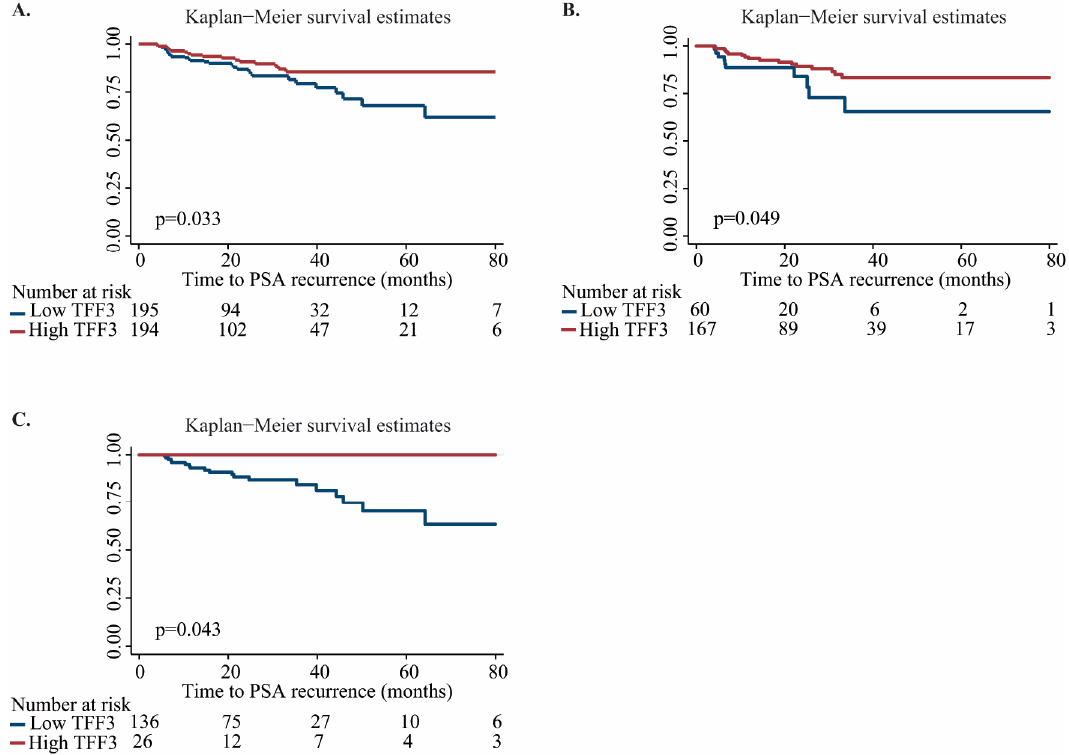
Figure 3. Kaplan–Meier analysis of PSA recurence-free survival based on TFF3 RNA expression levels (low vs. high) in TCGA PC samples. ( A ) all PC samples; ( B ) PC samples with low ERG RNA expression; and ( C ) PC samples with high ERG RNA expression. Blue line, low TFF3 RNA expression; Red line, high TFF3 RNA expression; p , p -value (log-rank test).